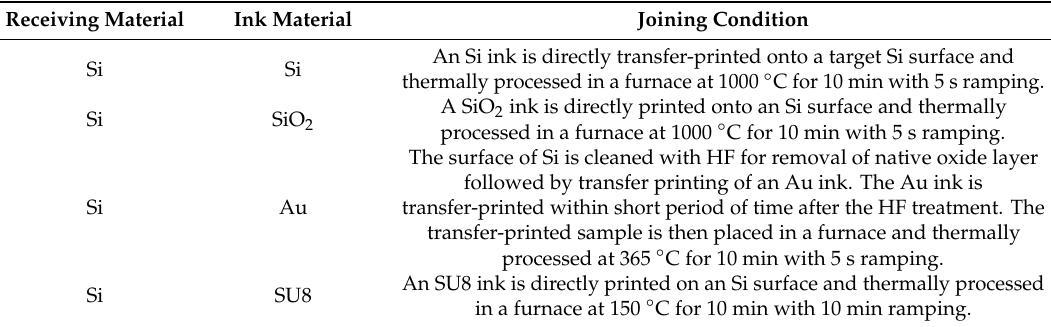
Table 2. Common material joining conditions implemented in micro-LEGO